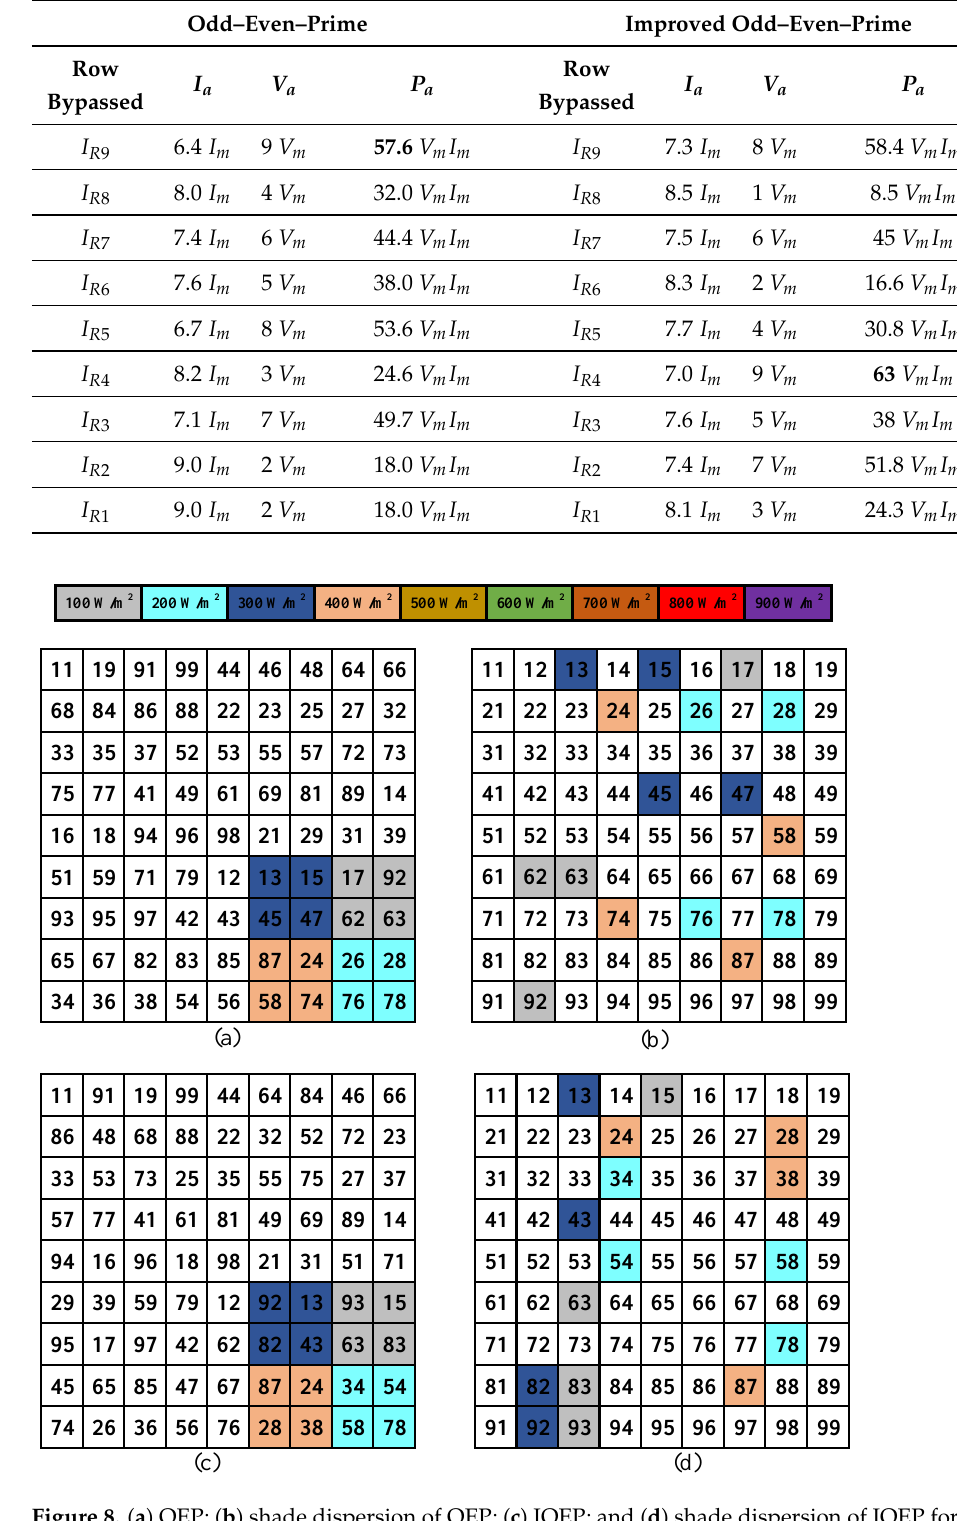
Figure 8. ( a ) OEP; ( b ) shade dispersion of OEP; ( c ) IOEP; and ( d ) shade dispersion of IOEP for 9 × 9 PV array at Bottom-Right PSC. The voltage–power characteristics of case-IV (Bottom-Right) are shown in the Figure